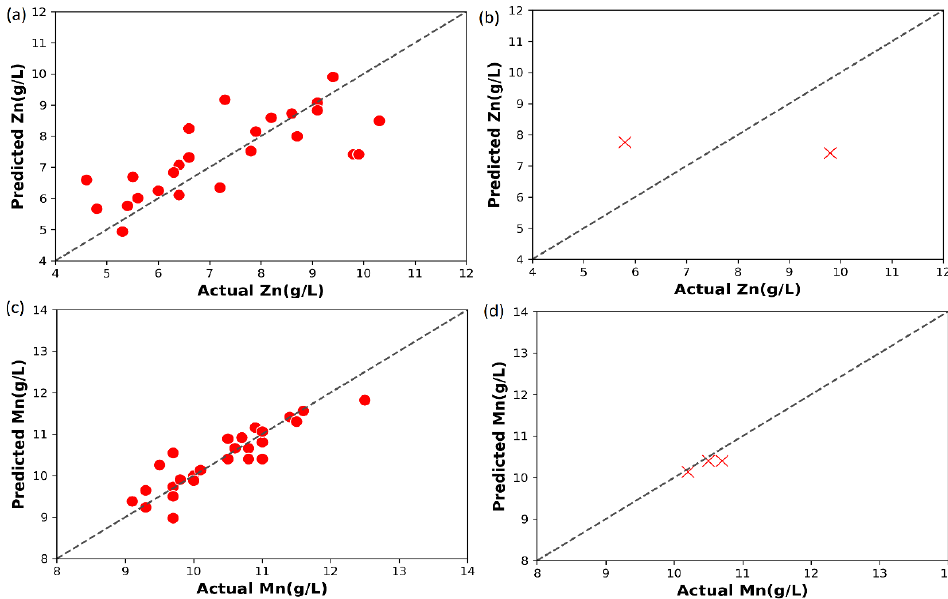
Figure 6. Actual versus linear regression-based predicted ( a ) Zn (g/L) training, ( b ) Zn (g/L) testing, ( c ) Mn (g/L) training and ( d ) Mn (g/L) testing data.